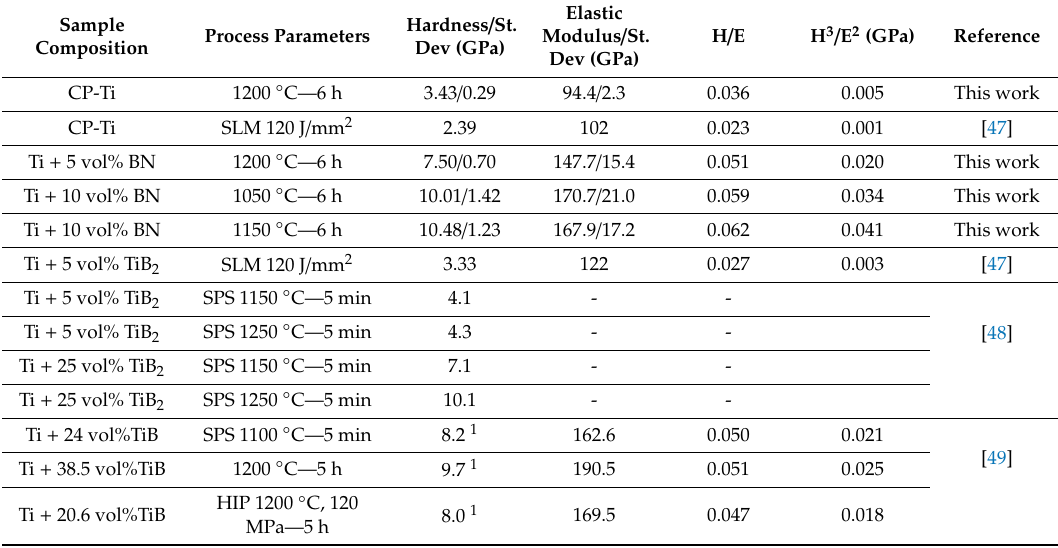
Table 1. Summary of key results from nanoindentation tests, with results from other works for